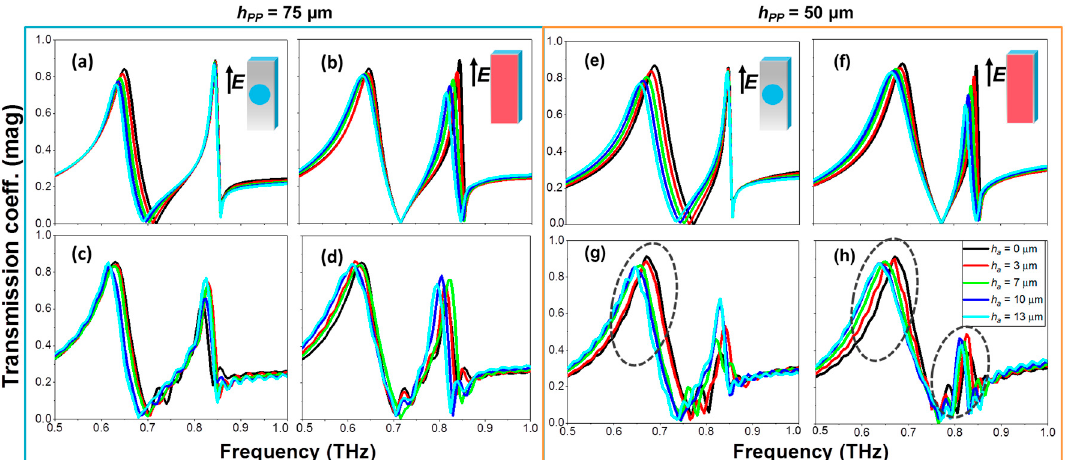
Figure 4. Transmission coefficient magnitude at the regular EOT regime in HA metasurfaces with h pp = 75 µ m ( a – d ) and h pp = 50 µ m ( e – f ) µ m under normal incidence and different analyte thicknesses: h a = 0 µ m (black); h a = 3 µ m (red); 7 µ m (green); 10 µ m (dark blue); 13 µ m (cyan) for the anomalous EOT. Simulated (top) and measured (bottom) results. The dashed ellipse in panels ( f , g ) highlights the regions where sensing is feasible. Insets in panels ( a , b , e , f ) depict schematically each scenario, following the colour convention of Figure 1. Table 1. Average sensitivity and FOM achieved in the configurations shown in Figures 3 and 4, experimental results.